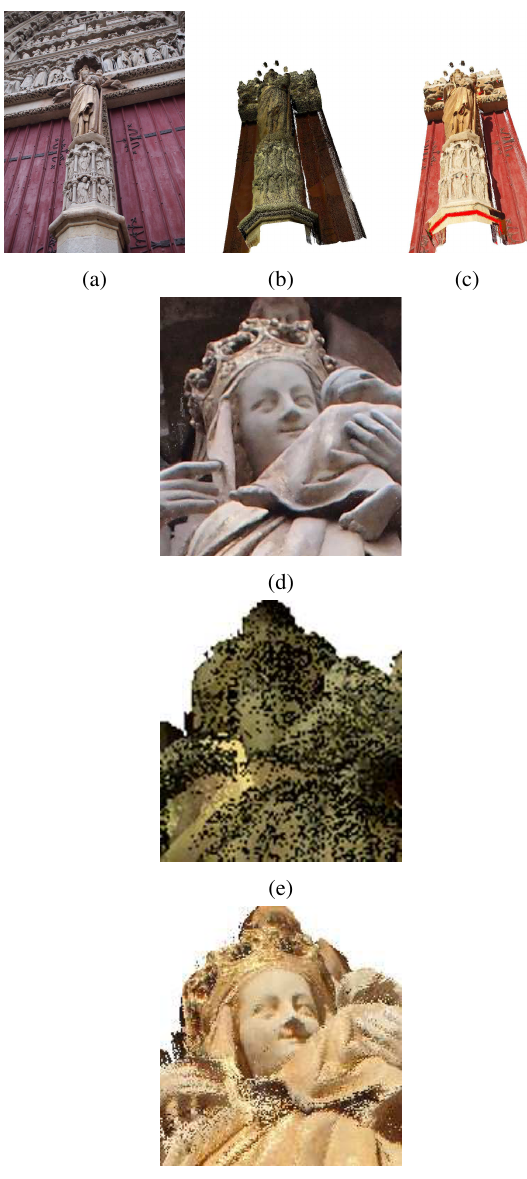
Figure 12: (a) A Virgin Mary statue image from a low-angle shot. (b) The original point cloud of the Virgin Mary from the same camera pose. (c) The colored point cloud of the Virgin Mary from the same camera pose. (d-f)A focus on the color resolution of the Virgin’s